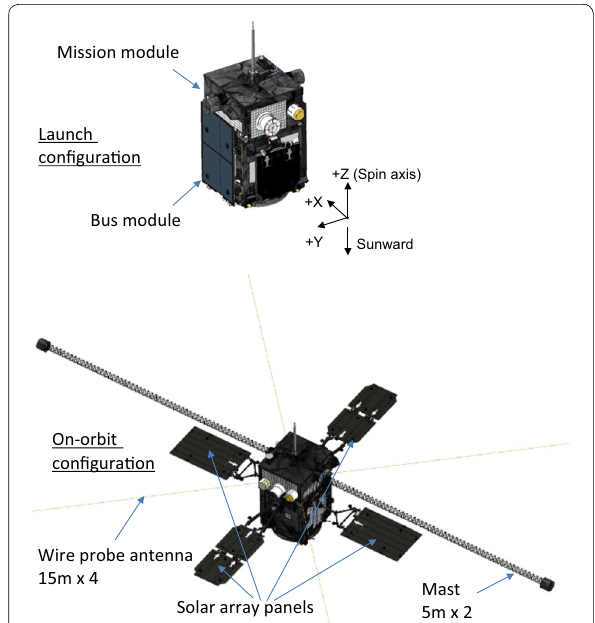
Fig. 2 Image of the ERG satellite showing the standard bus module (the lower part of the satellite) and the mission‑specific module (the upper part of the satellite). The satellite deploys four solar‑array panels (SAP) just after entering its orbit and four sets of 15‑m‑long wire probe antennas and two sets of 5‑m extendable masts once it is